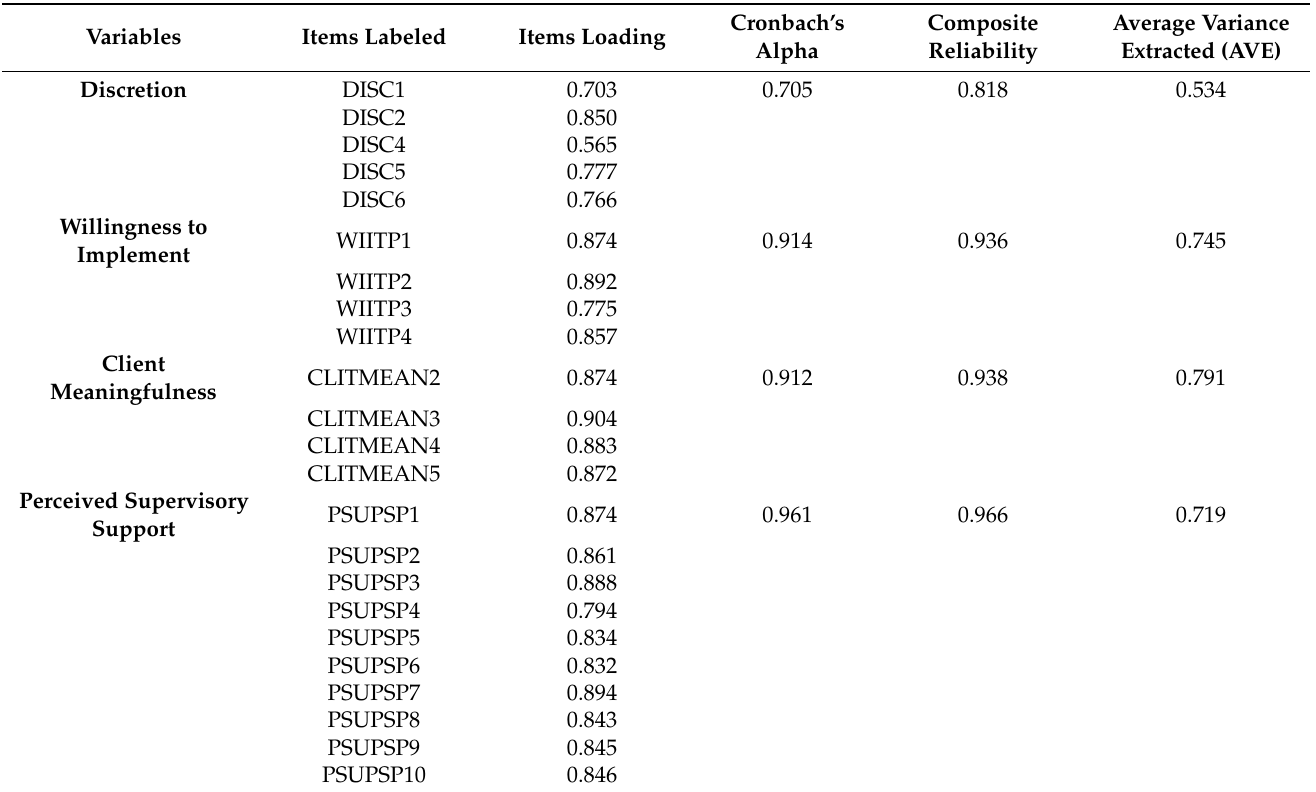
Table 1. Measurement model assessment, items loading, reliability, and validity.